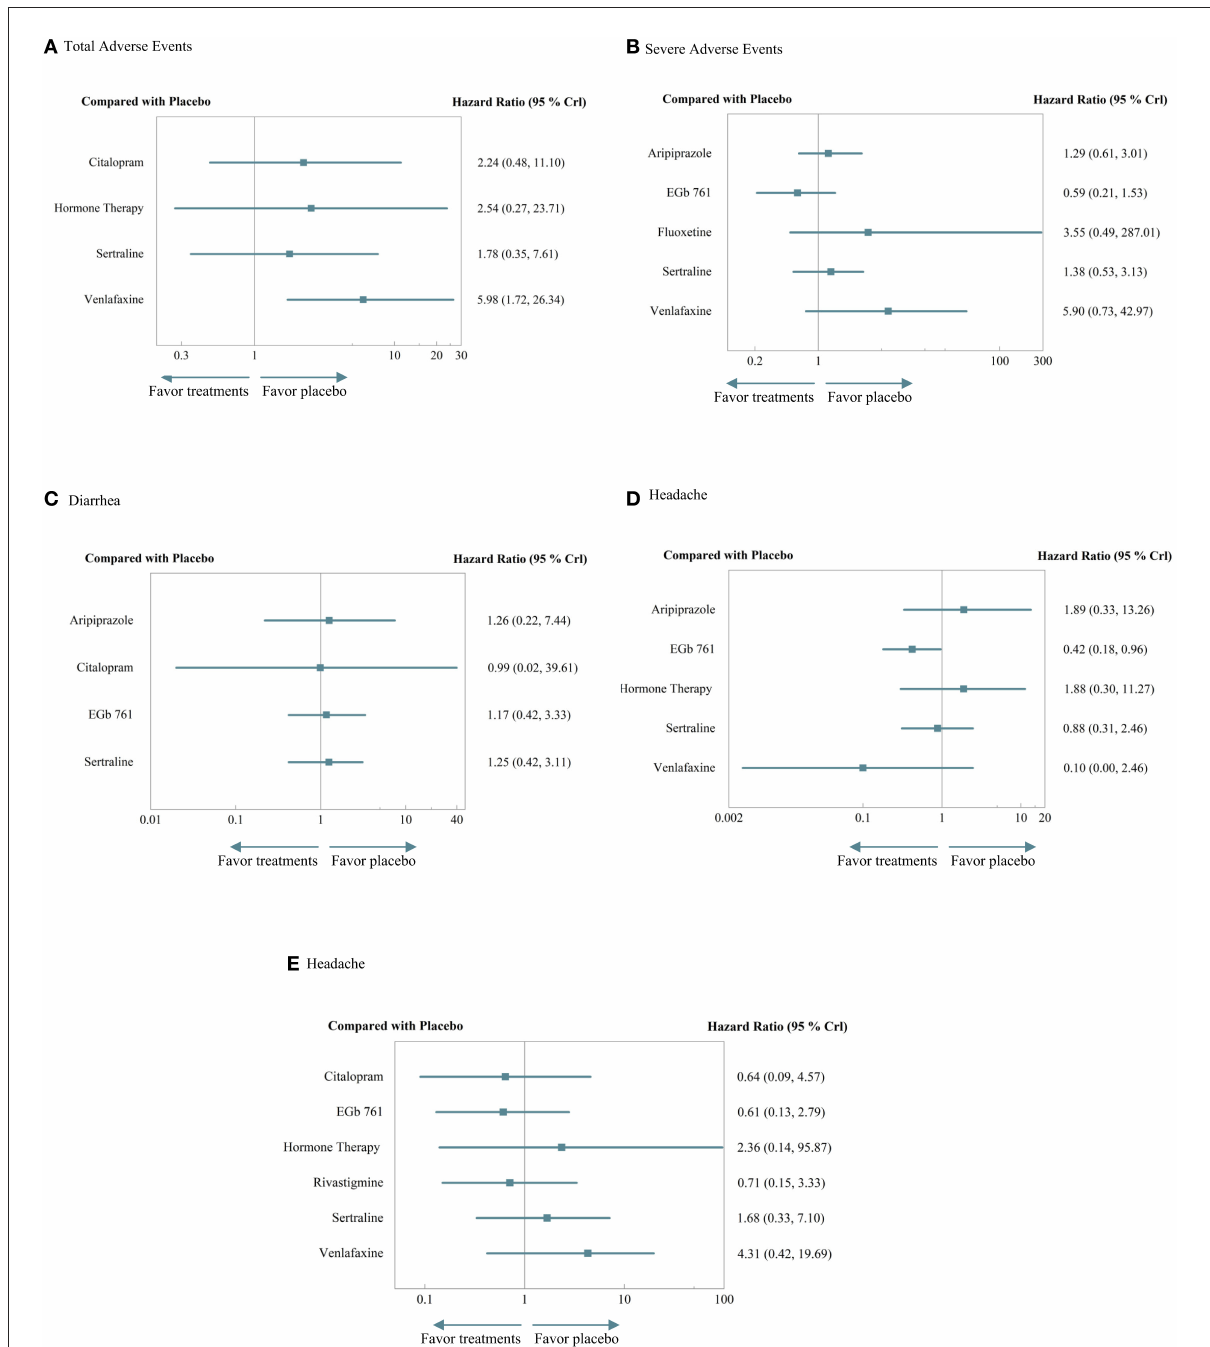
across the direct comparisons in the distribution of study the potential effect modifiers on transitivity. Funnel